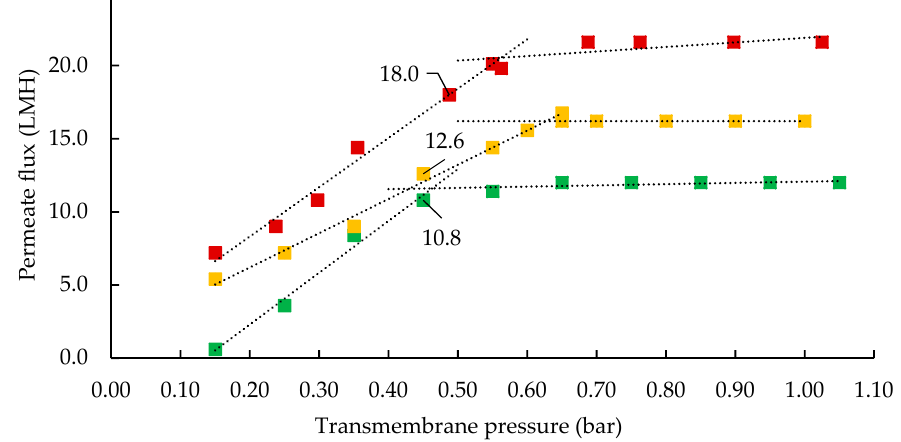
Figure 1. Flux excursion plot showing permeate flux as a function of transmembrane pressure (TMP) during ultrafiltration of skim milk in full recirculation mode with 10 kDa membrane at 5 ± 0.5 ( ■ ), 20 ± 0.5 ( ■ ), and 50 ± 0.5 °C ( ■ ). To study temperature as a single test variable, an initial TMP of 0.45–0.5 bar was selected as initial TMP to operate ultrafiltration (UF) experiments near the sub-critical flux region. Cross flow velocity was kept constant at 0.34 m / s. LMH: L / m 2 /